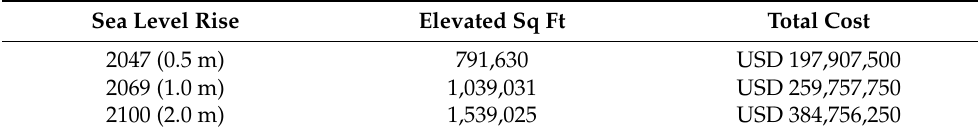
Table 3. Estimated retrofit costs of elevating structures in flood zones.